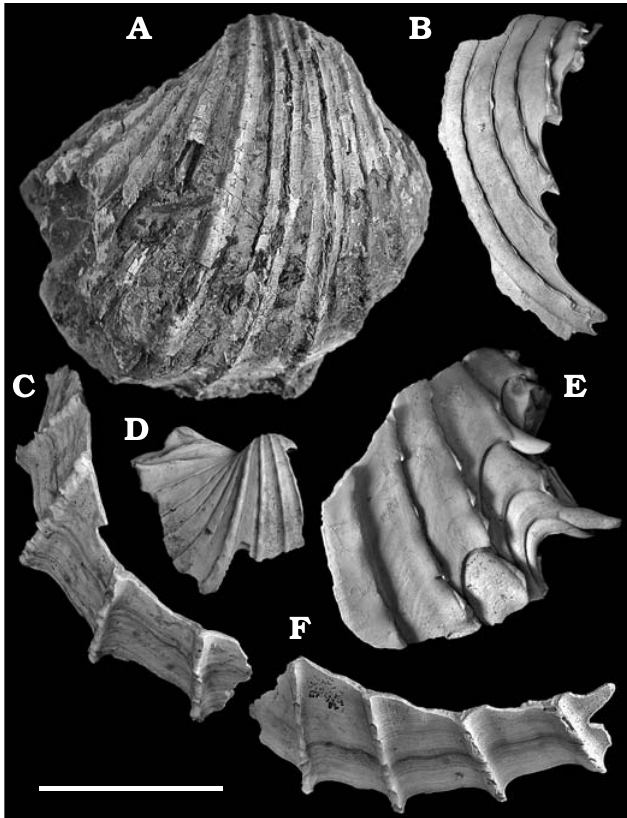
Fig. 12. Cardiid bivalve Procardium spp. A . Procardium cf. danubianum (Mayer, 1866), MRSN BS.131.03.003 (Bellardi and Sacco collection), Langhian (Miocene), Albugnano, Italy; external view. B – F . Procardium sp., RGM. 1309268 (van der Voort collection), Serravallian (Miocene), Seyithasan, Turkey; external views. Scale bar 30